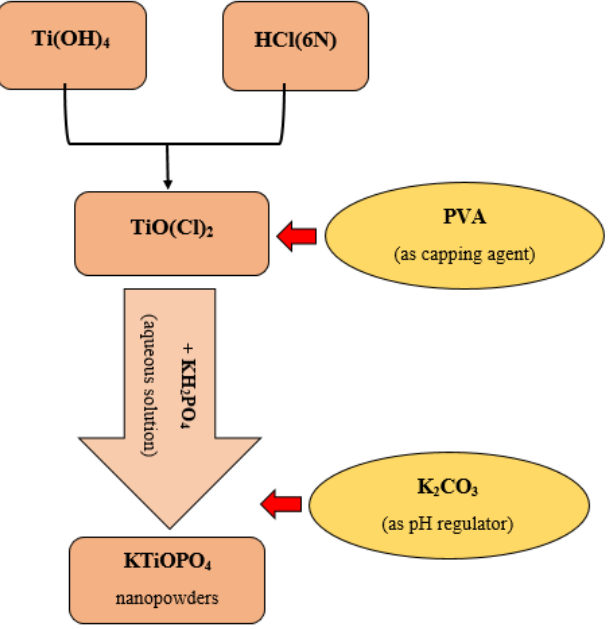
Figure 1. The synthesis diagram of KTP nanoparticles by co-precipitation